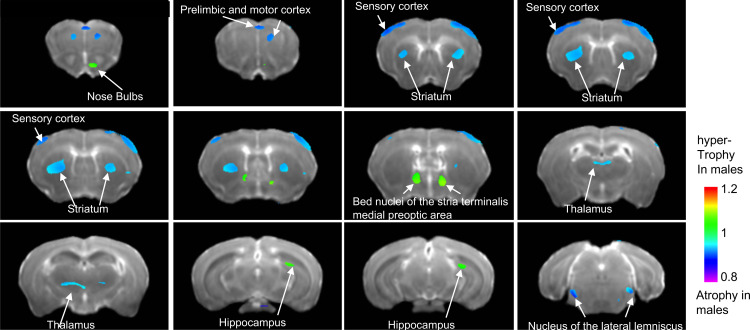
Effect of sex on local volumetric changes using voxel-based morphometric analysis, FDR < 0.3, p<0.0107, minimal cluster size = 25 voxels.1 = no change; <1 (blue) reduced volume in males; >1 (green) increased in males, n = 6 per rearing condition and sex.